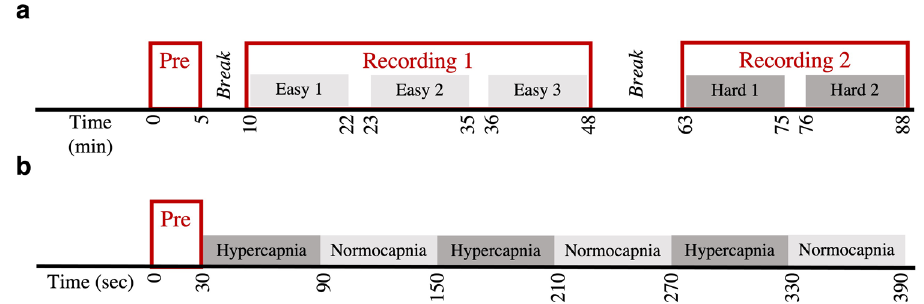
Figure 1. Experimental protocols. ( a ) In cognitive task, each participant started with a brief instructional session regarding UAS controls and task objectives, followed by five 12 min task conditions of varying difficulties. The first three task conditions were of easier difficulty, while the last two were of harder difficulty. A 5 and 15-min breaks were given between instructional and first easy condition, and last easy and first hard condition. ( b ) In hypercapnic task, each participant began with a 30 s baseline period (Room Air – 0.04% CO 2 ), followed by three hypercapnic (5% CO 2 ) and normocapnic (Room Air) conditions of 60 s